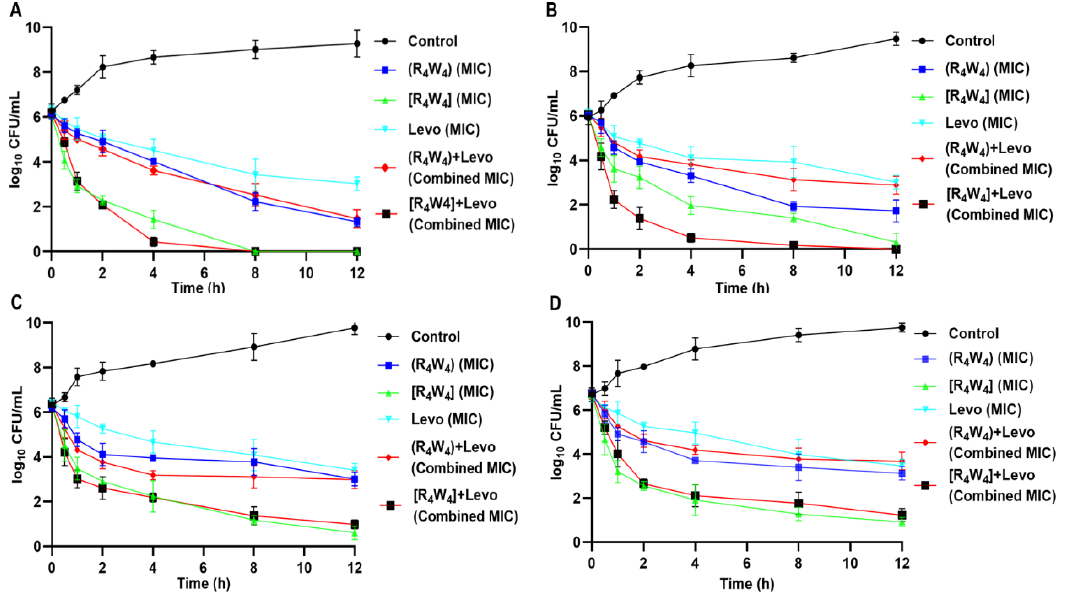
Figure 4. Time-dependent kill study of the test compounds against drug-resistant bacterial strains of ( A ) S. aureus (ATCC BAA-1556), ( B ) E. coli (ATCC BAA-2452), ( C ) P. aeruginosa (ATCC BAA-1744), and ( D ) K. pneumoniae (ATCC BAA-1705). The data represent the results of the experiment performed in triplicate.